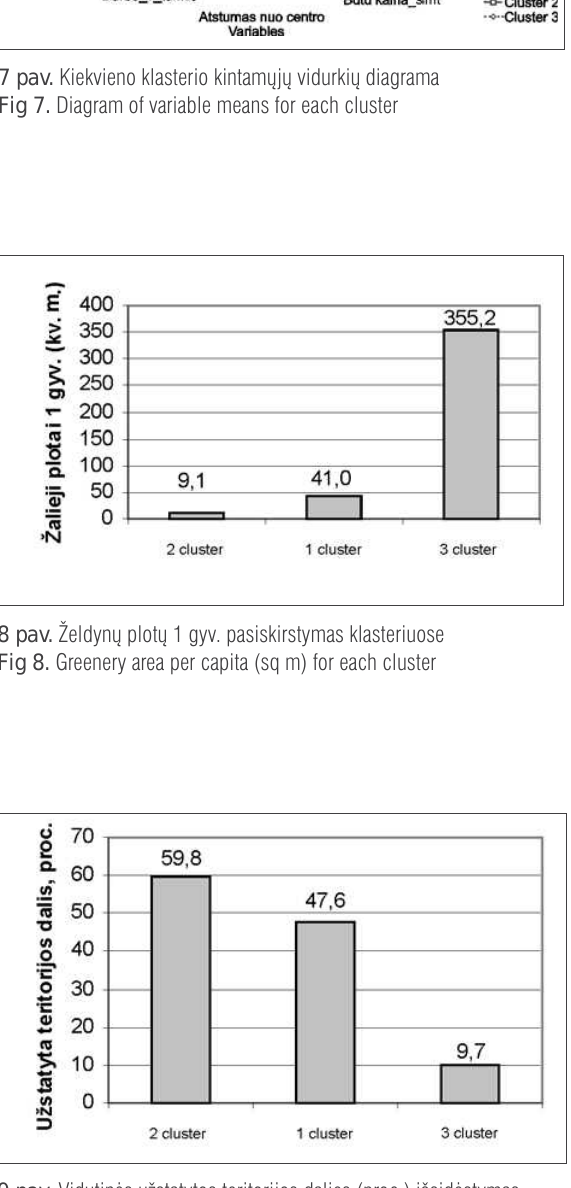
Fig 9. Percentage of built-up territory for each